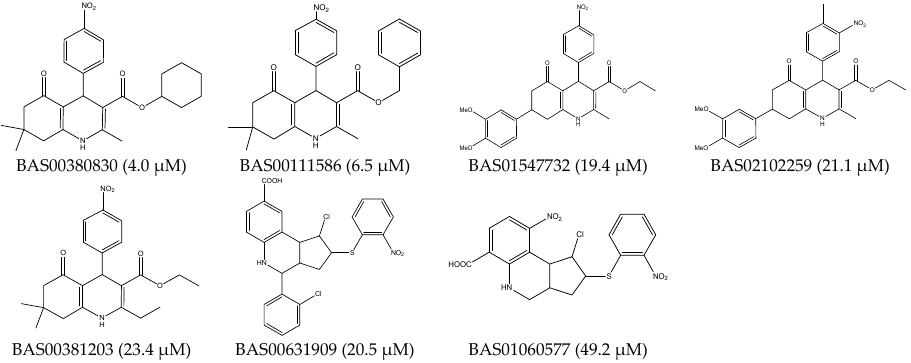
Figure 7. Chemical structures and IC 50 of the compounds in the training set for the construction of GALAHAD pharmacophore model.